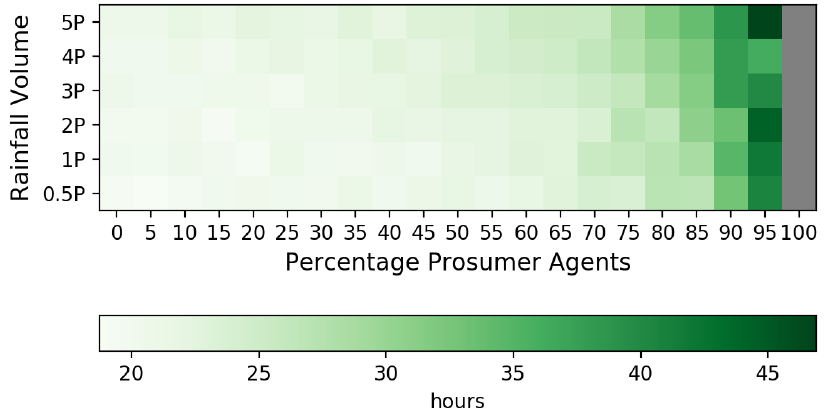
Figure 12. Water age calculated for all scenarios using Equation